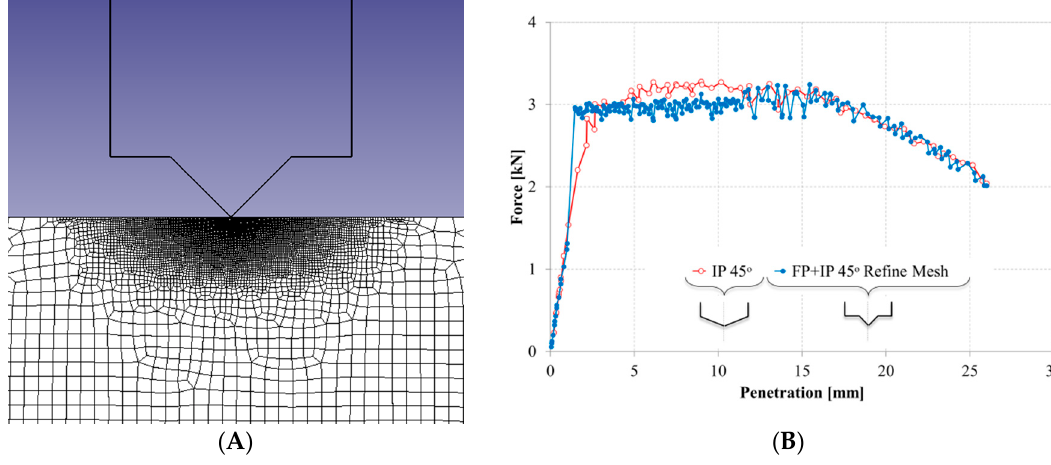
Figure 10. Refined mesh implementation ( A ) and results ( B ). Table 2. New mesh implemented.